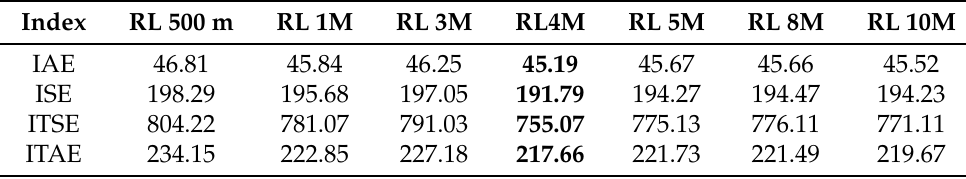
Table 1. Performance indexes for each algorithm. In bold, the better case.